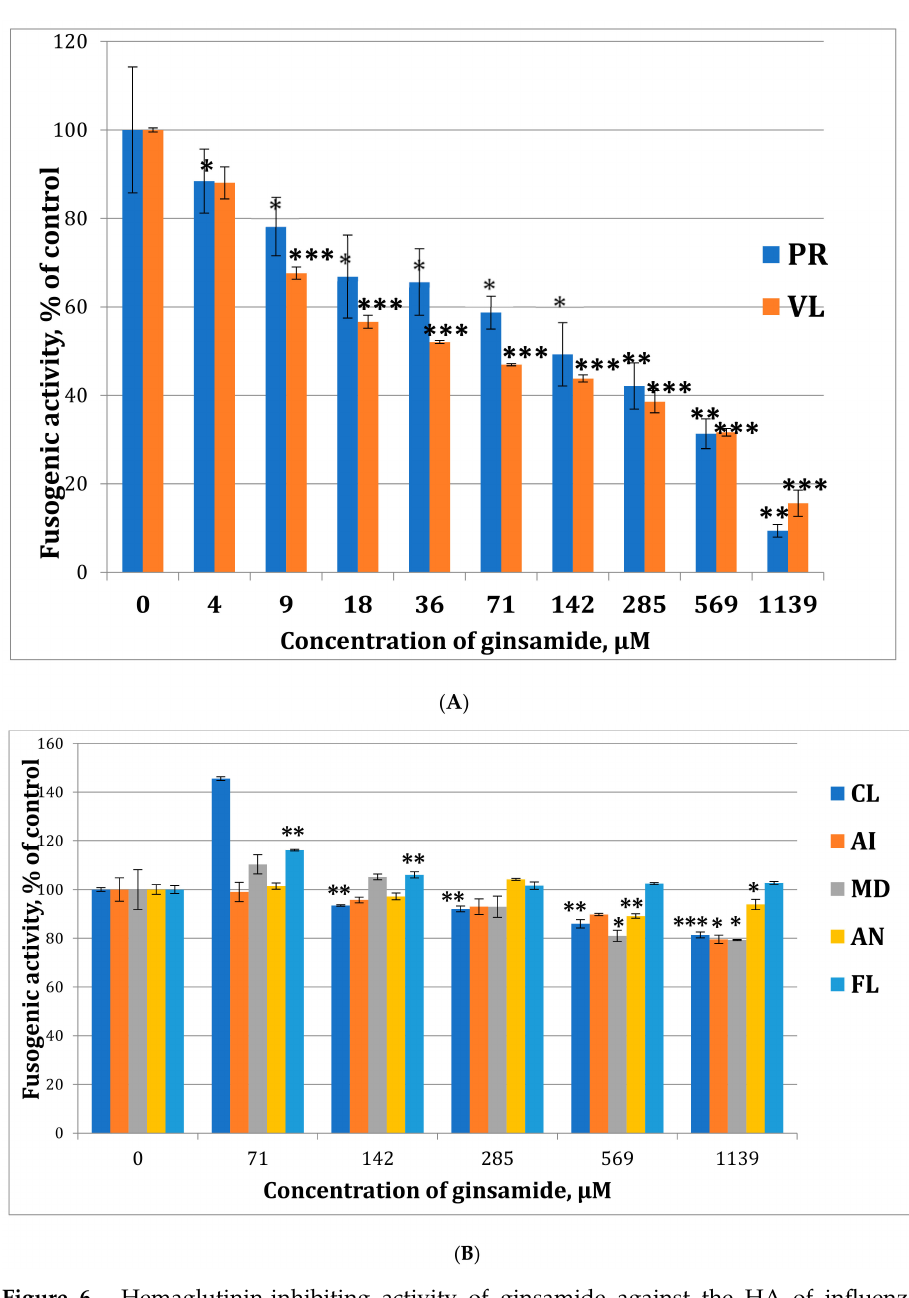
Figure 6. Hemaglutinin-inhibiting activity of ginsamide against the HA of influenza ( A , B ) viruses. Panel ( A ): Hemaglutinin-inhibiting activity of ginsamide against the HA of A/Puerto Rico/8/34 and A/Vladivostok/2/2009 (H1N1) viruses. Panel ( B ): Hemaglutinin-inhibiting ac- tivity of ginsamide against the HA of A/California/7/2009 (H1N1); A/Aichi/2/1968 (H3N2); A/Mallard/Pennsylvania/1984 (H5N2); A/Anhui/1/2013 (H7N9); B/Florida/4/2006 viruses. Gin- samide (0–1139 µ M) was mixed with 128 hemagglutinating units of the corresponding influenza virus, incubated at room temperature for 30 min, and mixed with 0.75% chicken erythrocytes. Plates were incubated for 1 h at +4 ◦ C, 150 µ L of supernatant was removed, and 150 µ L of MES buffer (0.1 M 37 ◦ C. After sedimentation of the erythrocytes at 1200 rpm for 6 min, the optical density in the